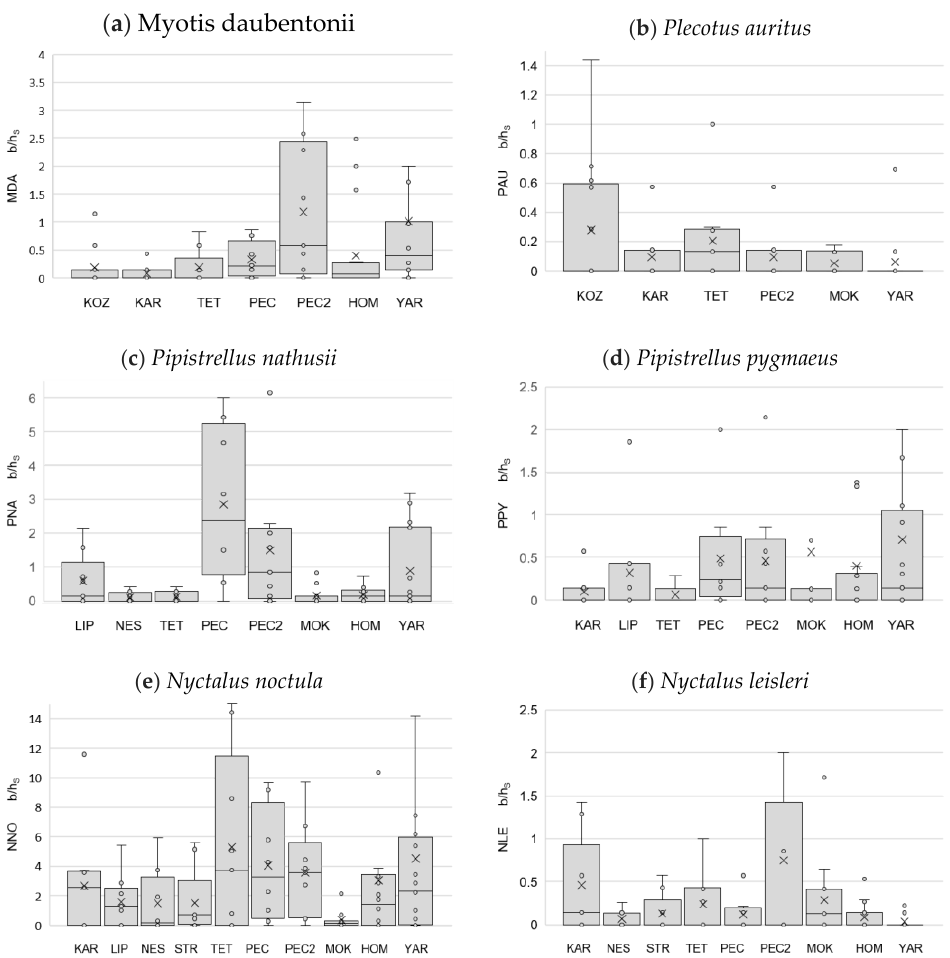
Figure 10. The variability of b/h S index between different study plots for six most abundant bat species (( a )–( f )—species name). “ × ” denotes average; “—” median; dots—each night of mist-netting. species ( a - f – species name) . “×” denotes average ; “—” median ; dots – each night of mist-netting. Some outliers are not shown in the figure: ( a ) YAR—7.5; ( d ) MOK—5.2, HOM—3.5, and YAR—4.6; Some outliers are not shown in the figure: ( a ) YAR — 7.5; ( d ) MOK — 5.2, HOM — 3.5, and YAR — 4.6; ( e ) HOM—16.7 and YAR—26.6; ( f ) ( e ) HOM — 16.7 and YAR — 26.6; ( f ) PEC2 — 3.8.